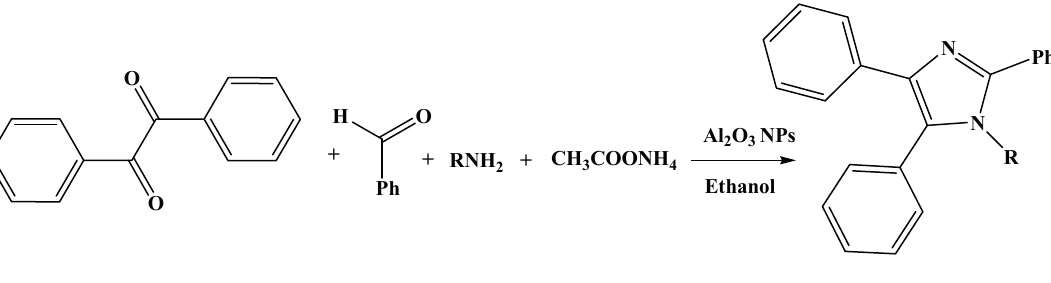
Scheme 1. Tetraaryl substituted imidazoles using multi-component